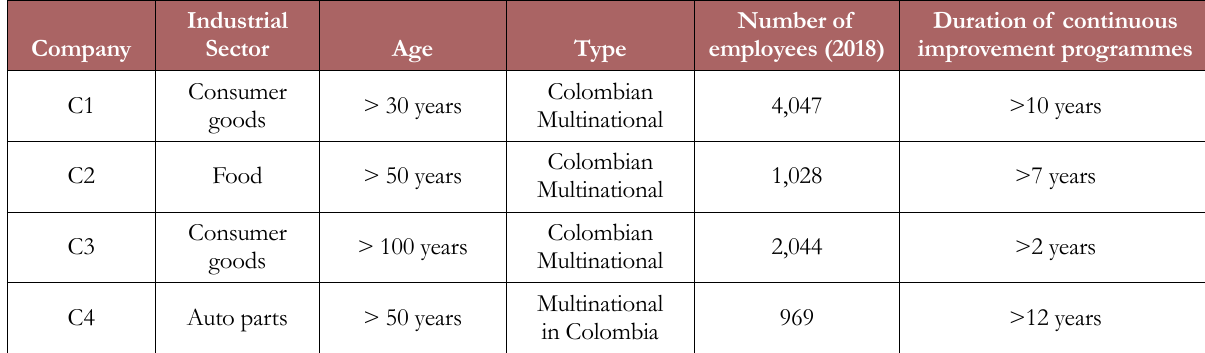
Table 3. Characteristics of the companies participating in the